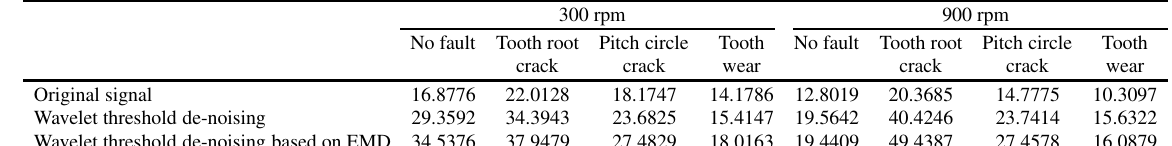
Table 1 The SNR for various faults in different running conditions